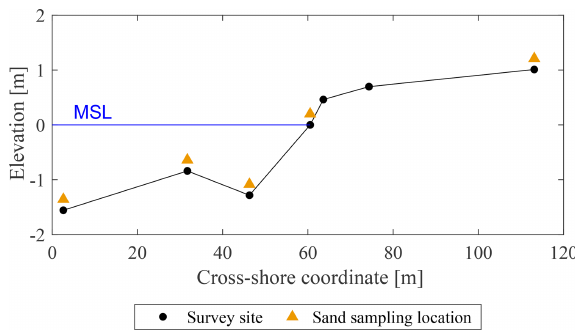
Figure 2. Typical cross-shore profile along the Bay of Lalzit (ex- ample of section 2; see Fig. 3a). It is possible to note the presence of the submerged bar some tens of metres away from the